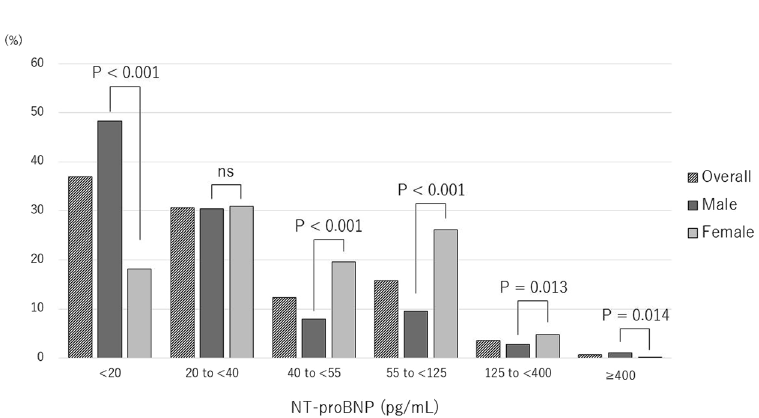
Figure 1. Plasma concentrations of NT-proBNP ( A ), HMW-adiponectin ( B ), and hsTnT ( C ) in the total cohort and by sex. Comparisons between male and female were performed by Mann-Whitney U test.